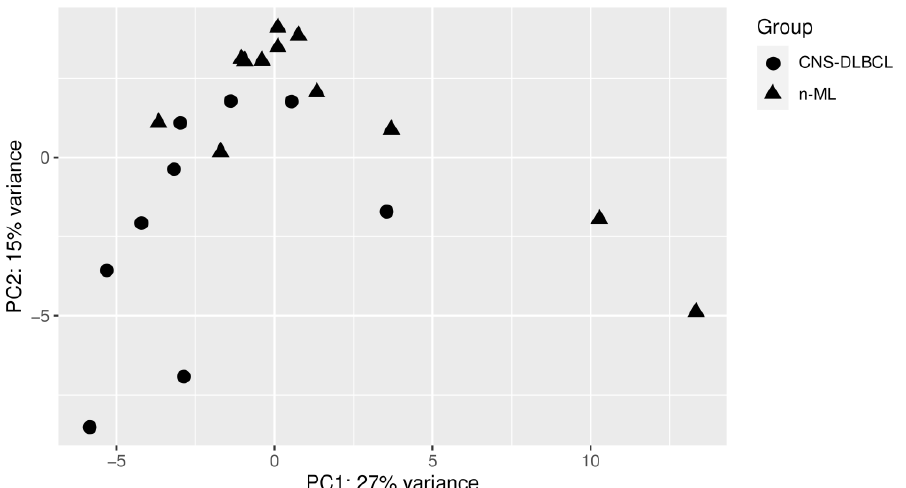
Figure 1. PCA of the cerebrospinal fluid samples from patients with primary diffuse large B-cell lymphoma of the central nervous system (CNS DLBCL, n = 9) and non-malignant diseases (n-ML, n = 12).